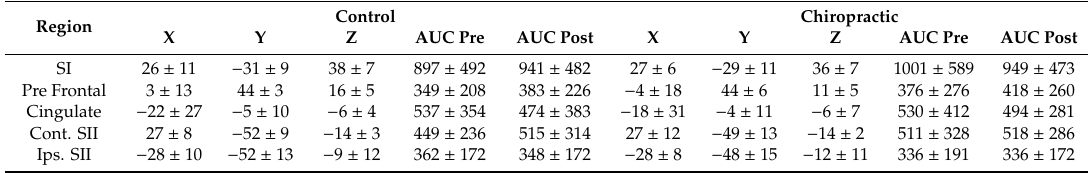
Table 4. Coordinates (Talairach) and areas under curve (AUCs) of brain sources. Region